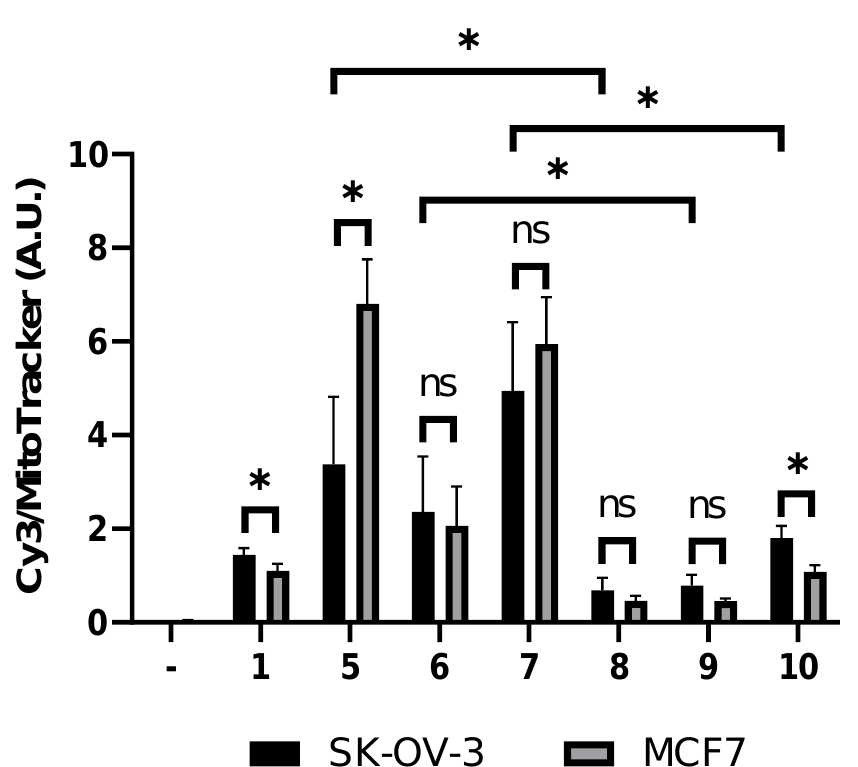
Figure 4. Flow cytometry analysis of Cy3-containing conjugate uptakes by SK-OV-3 and MCF7 cells. Cells were treated with 10 µ M of the indicated conjugate for 10 min at 37 ◦ C, washed, stained with 50 nM MitoTracker Green FMfor 10 min at 37 ◦ C, washed, trypsinized, and subjected to flow cytometry analysis. Cellular uptakes are shown as the ratios of Cy3 and MitoTracker Green FM fluorescence. Mean ratios ± standard deviations are calculated from three biological replicates and plotted in arbitrary unit (A.U.). The negative control (-) refers to cells only stained with MitoTracker Green FM. Representative flow cytometry scatter plots are shown in Figure S8. Statistical analysis was performed by applying the unpaired two-tailed t -test test, performed using GraphPad Prism version 9 for Windows, GraphPad Software, La Jolla California USA, www.graphpad.com. ns = not statistically significant, * = p < 0.05.